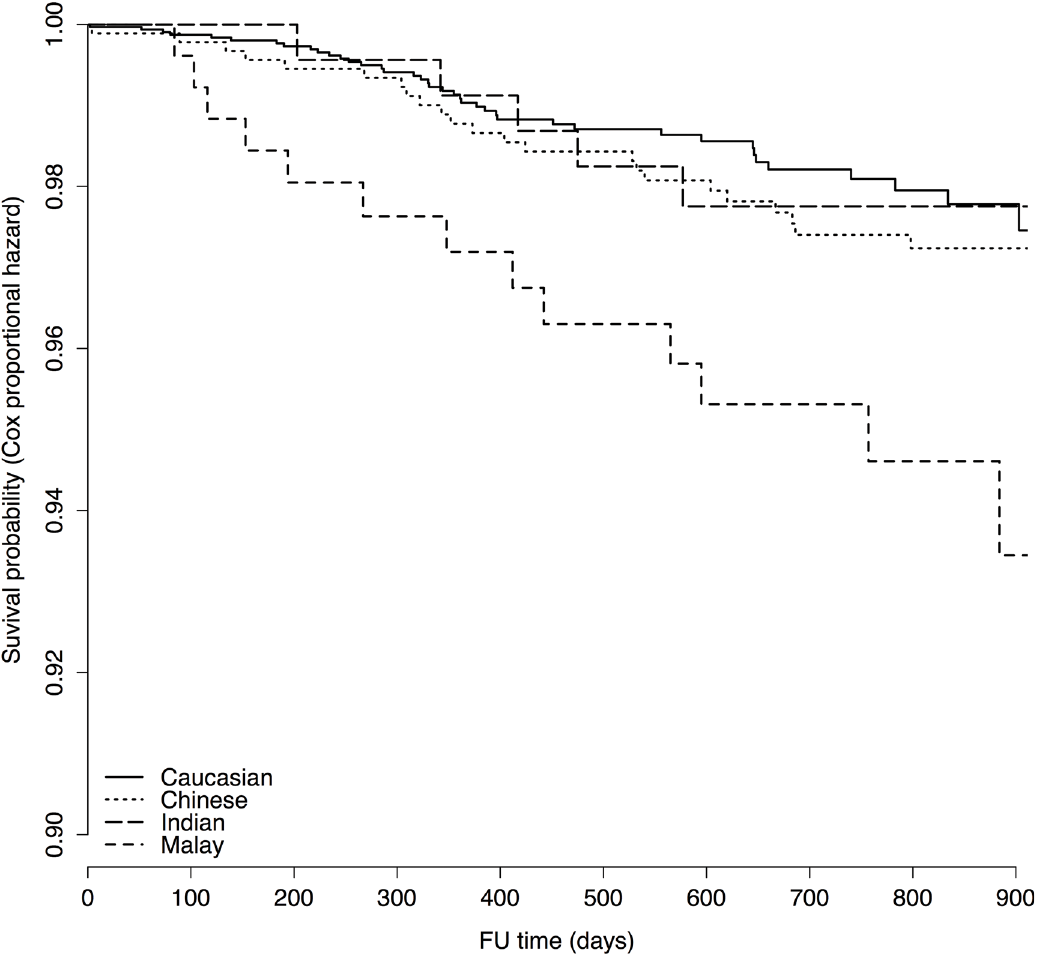
Fig 4. Adjusted survival probability from multivariable Cox regression analysis by ethnicity. Survival probability derived from multivariable Cox regression analysis. Ethnicity-specific curves are adjusted for: age, gender, indication for angiography, conclusion from angiography, diabetes, dyslipidemia, previous ACS, statin use, platelet inhibitor use, beta blocker use and RAAS-inhibiting medication use. White, Chinese and Indian ethnicity were significantly associated with a better survival as compared to Malay ethnicity (Whites: HR 0.4 [0.2 – 0.8], p = 0.009, Chinese: HR 0.5 [0.3 – 0.98], p = 0.044, Indians HR 0.4 [0.1 – 0.98], p =